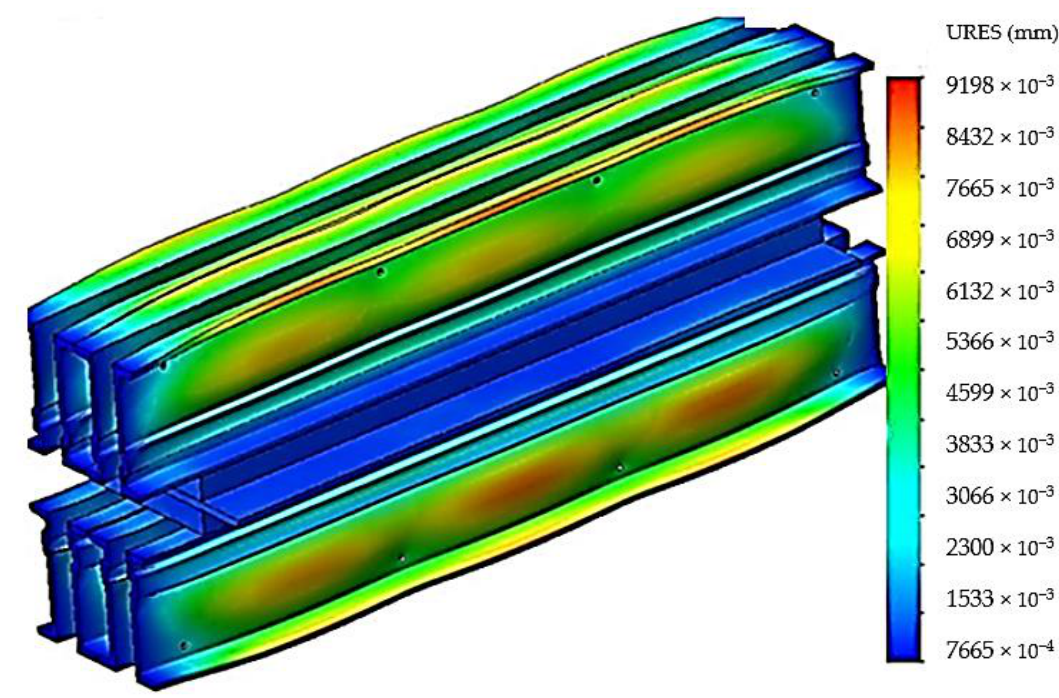
Figure 8. The deformations that appear in the constructive elements of the belt vulcanization press when using four spacers.